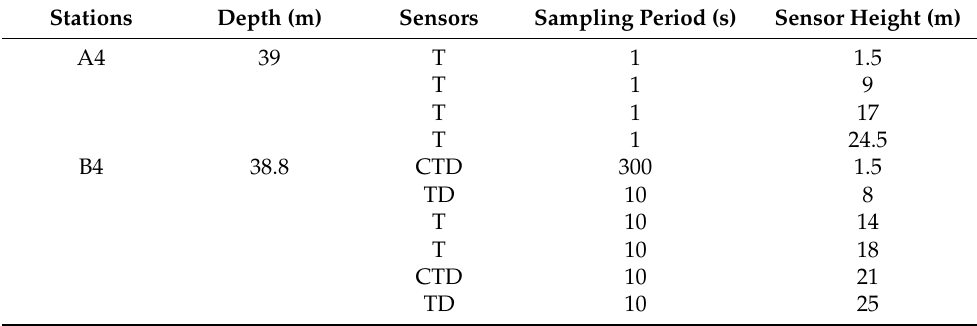
Figure 1. ( a ) Bathymetry of the Yellow Sea. ( b ) Inset of the outlined square in ( a ), indicating the location of the mooring station (red triangle). ( c ) Instrument configuration schematic of the T-chain at Stns. A4 and B4. Table 1. Stations, sensors, frequency, and sensor height of the mooring observations.